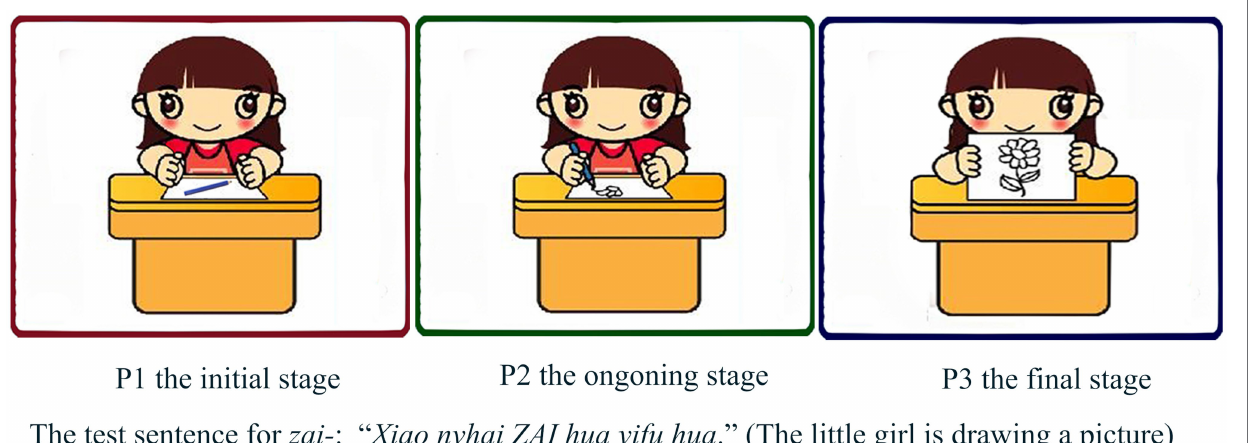
FIGURE 1 | Example for the aspect markers zai - and - le .